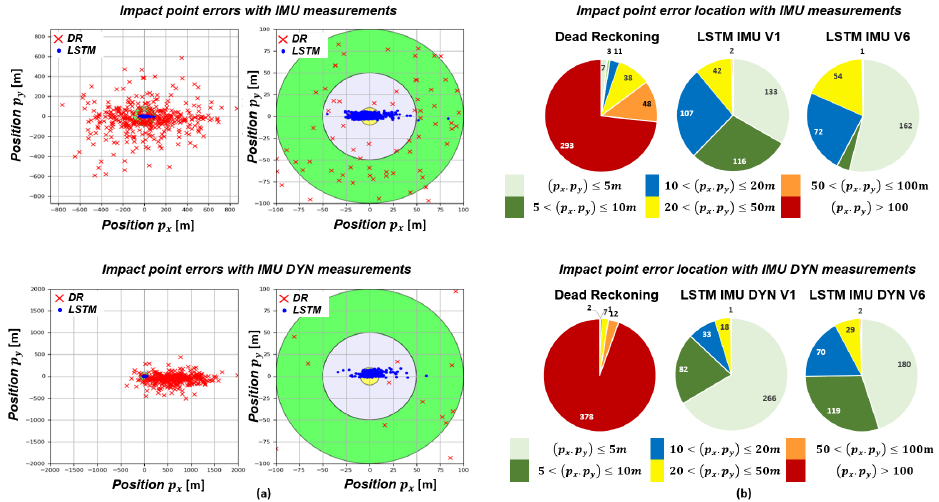
Figure 13. ( a ) Errors at impact point obtained by LSTM IMU , V LSTM IMU , V and LSTM IMU DYN , V 6 point error